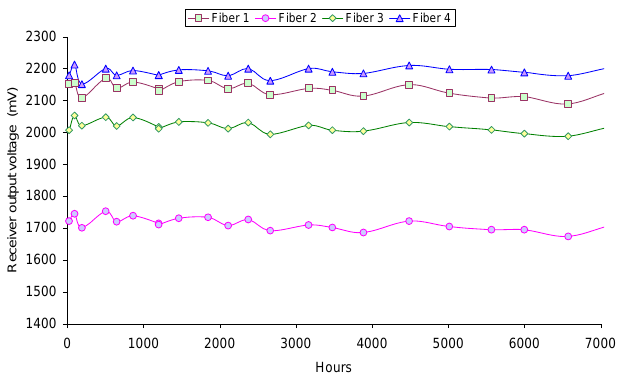
Figure 20. Receivers’ output voltage along the accelerated test for polymer optical fiber dipped in acid sulphuric